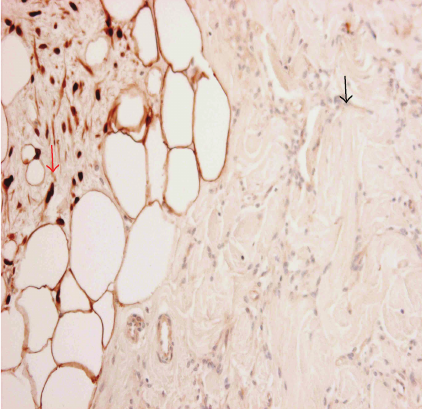
Figure 3: Mammary myofibroblastoma (MFB) with admixed but distinct spindle cell lipoma component. S-100 decorates spindle cells of spindle cell lipoma component (red arrow) but not MFB component (black arrow), immunoperoxidase,